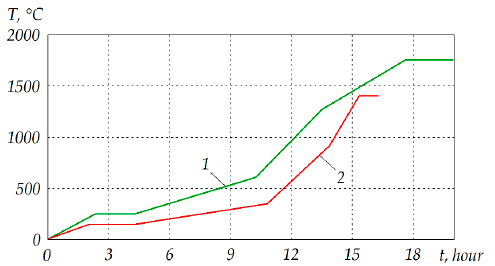
Figure 1. Cyclograms of heating and high-temperature holding in thermal cycles of porous aluminum oxide ceramic technologies without additives of other metal oxides (1) and with two percent additives of titanium and manganese dioxides (2).